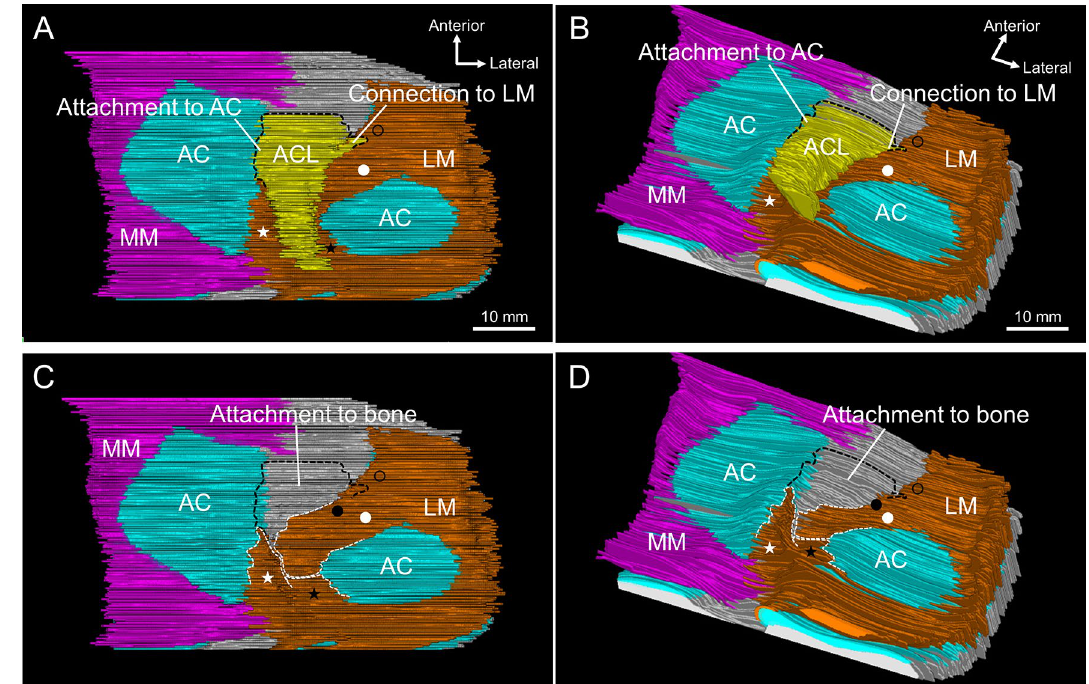
Figure 5. Three-dimensional relationships of the ACL with the AC and LM. ( A ) The superior aspect of the tibial side of the ACL and surrounding structures, reconstructed based on the serial histological sections (interval = 0.2 mm). The ACL is medially attached to the articular cartilage and laterally connected to the superficial layer of the outer fibers of the anterior horn of LM (black circle). ( B ) The posterolateral aspect of ( A ). ( C ) After removal of the ACL from ( A ). The deep layer of the outer (black dot) and inner fibers (white dot) extend into the intercondylar area. ( D ) The posterolateral aspect of ( C ). The articular cartilage in the area where the ACL is attached has an inclined surface facing laterally. AC, articular cartilage; ACL, anterior cruciate ligament; LM, lateral meniscus; MM, medial